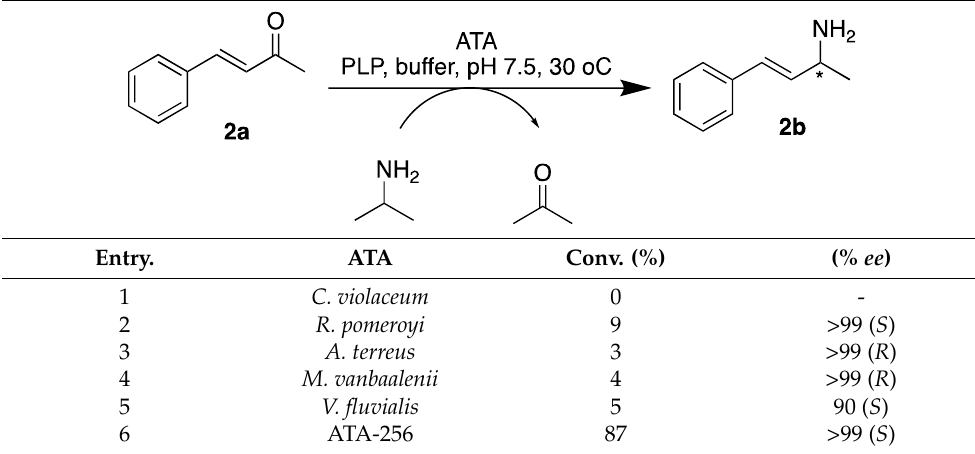
Table 2. Conversions and enantiomeric excess (% ee -values) for the amine product 2b obtained by asymmetric synthesis using isopropylamine (IPA) as a donor and crude cell lysate from E. coli , containing the overexpressed ATA.